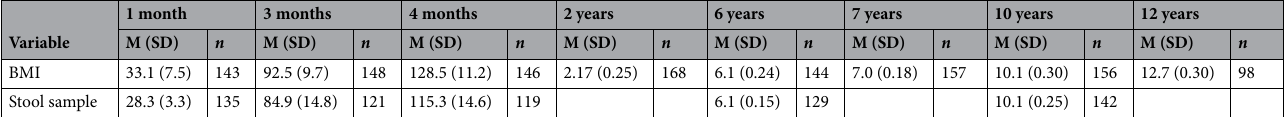
Table 1. Age of data collection in days. The exact day of collection for some stool samples (12.9%) was not recorded but still utilized in the analyses. All means and standard deviations of 2 years and onwards are reported in years rather than days.